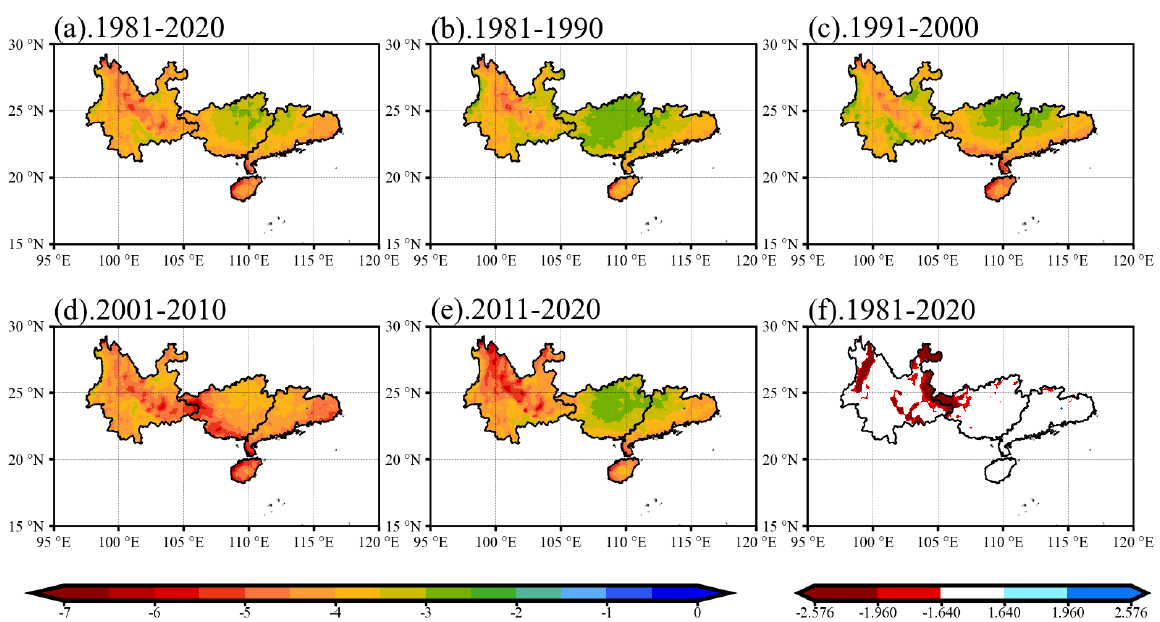
Figure 6. Distribution of the average SWDI of 1981 – 2020 ( a ), 1981 – 1990 ( b ), 1991 – 2000 ( c ), 2001 – 2010 ( d ), and 2011 – 2020 ( e ) and variation tendency from 1981 to 2020 ( f ).